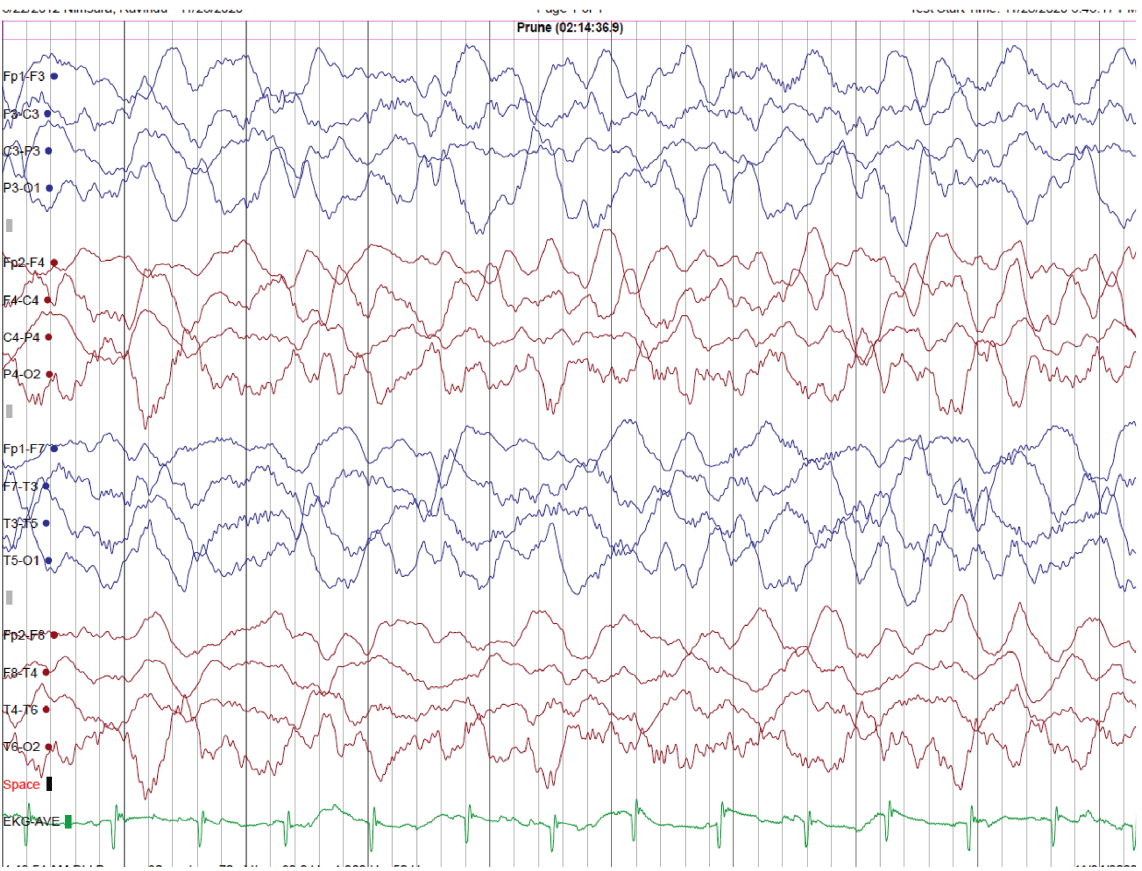
Figure 3: Abnormal EEG showing features of encephalopathy following sodium valproate (voltage